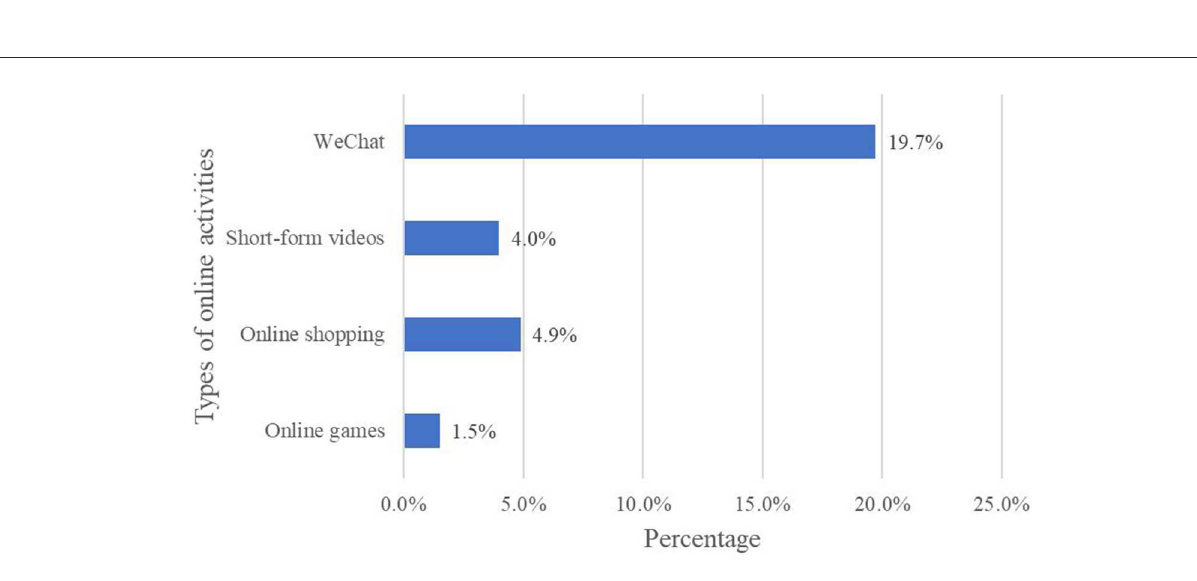
FIGURE2 Percentage of using different types of online